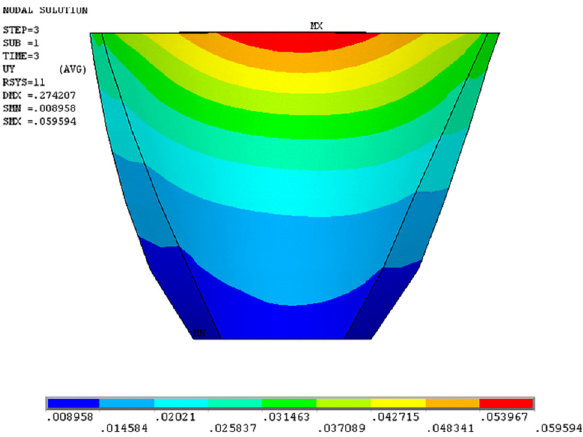
Figure 17: Radial displacement distribution of the downstream sur - face of the dam when K p = 1.